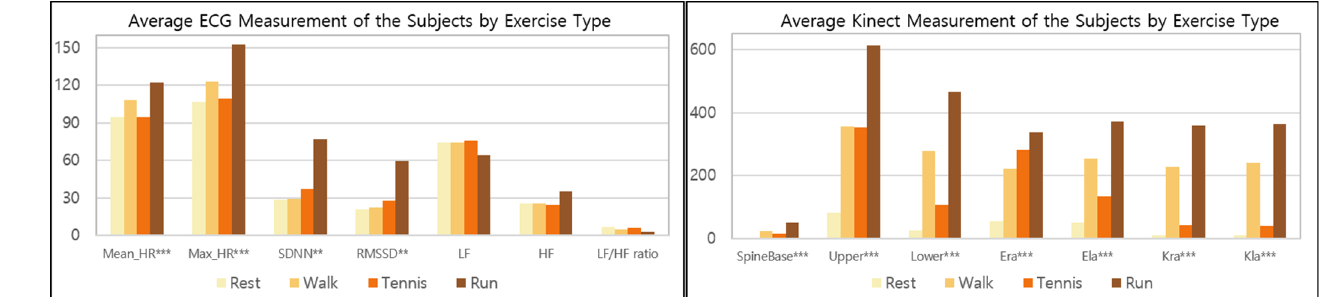
Figure 4. Kinect-based skeleton model for exercise.